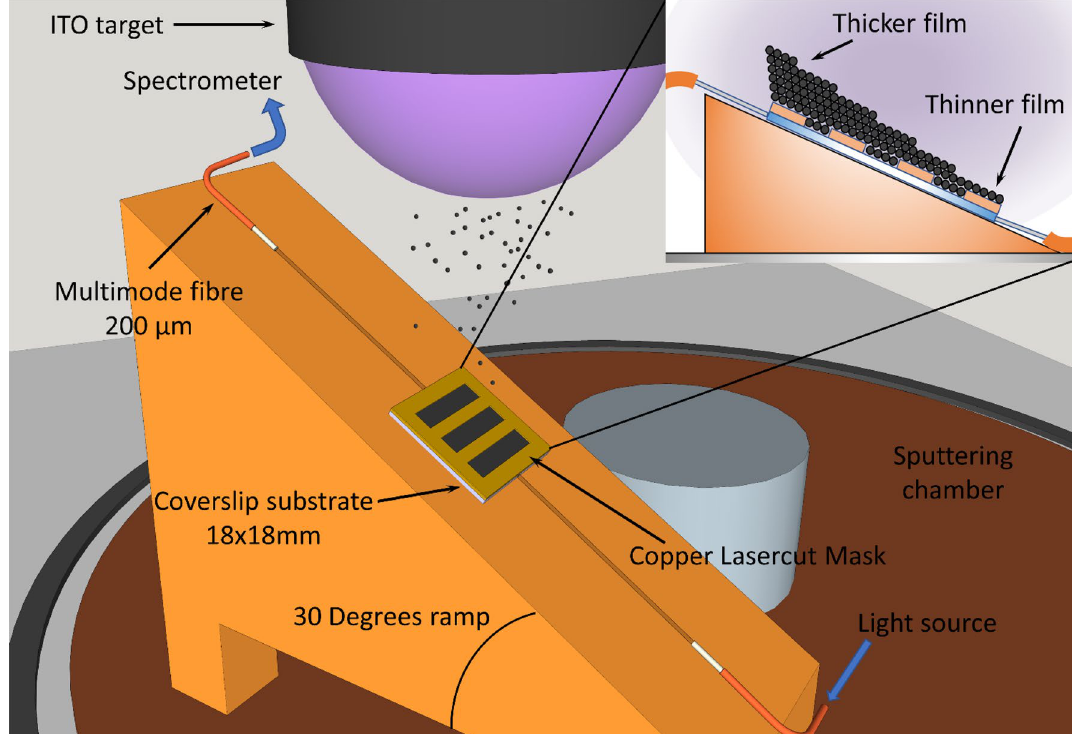
Figure 1. Deposition of a coating with a gradient in thickness. The waveguide, a simple coverslip for a microscope slide, was placed on a platform with a slope, which permitted creation of a non-uniform pattern on the surface of the coverslip